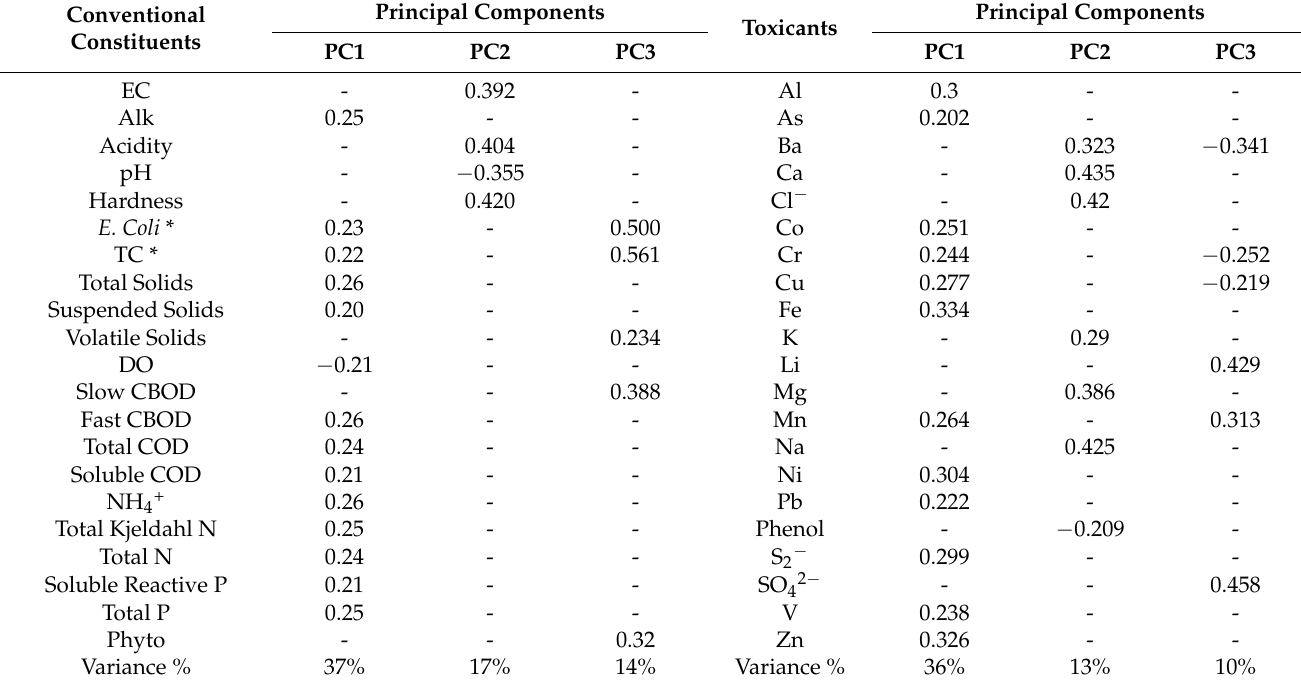
Table 5. PCA coefficients for relevant conventional and toxic